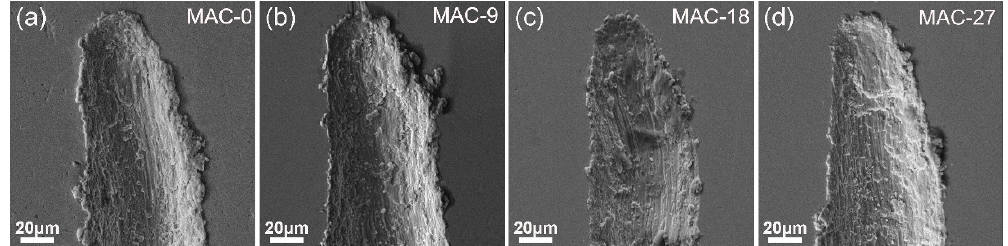
Figure 7. Comparison of the shear tongue: ( a ) MAC-0 sample, ( b ) MAC-9 sample, ( c ) MAC-18 sample, and ( d ) MAC-27 sample.